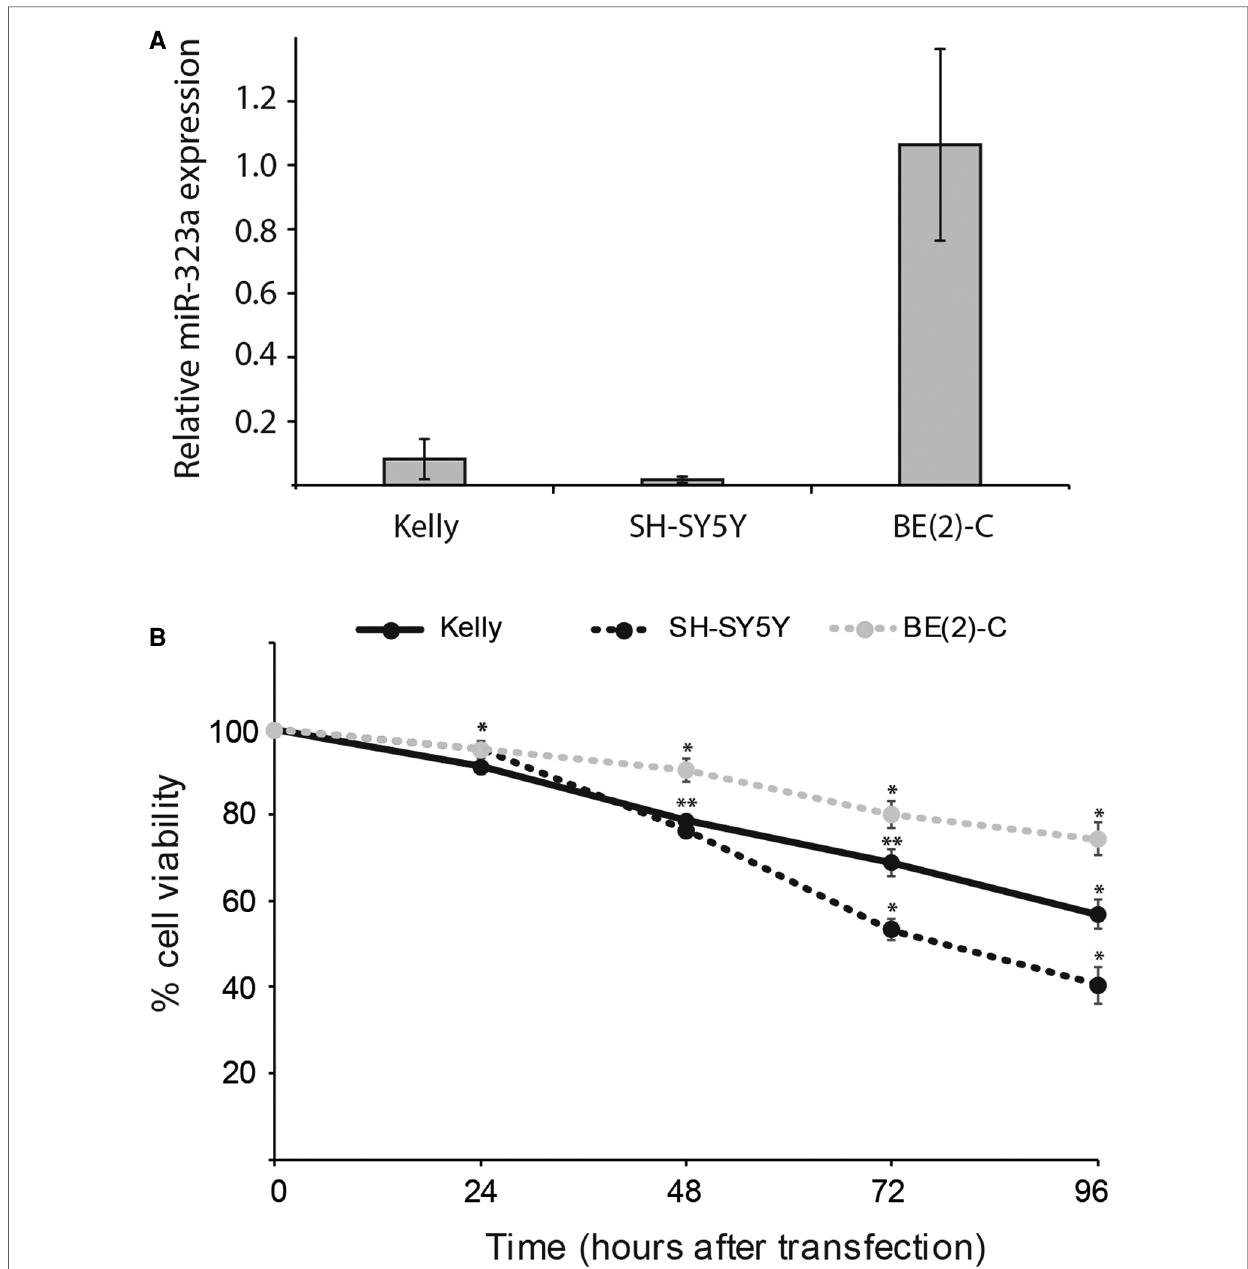
FIGURE 2 miR-323a-3p overexpression suppressed the growth and survival of neuroblastoma cells. (A) The basic expression of miR-323a-3p with respect to stably expressed miR-4286 in Kelly, SH-SY5Y and BE(2)-C cell lines were detected by RT-qPCR analysis. Data is presented as mean±SEM of at least three independent experiments, each repeated in triplicates. (B) Cell viability of the cell lines Kelly, SH-SY5Y and BE(2)-C at 24 h, 48 h, 72 h and 96 h post transfection with miR-323a-3p , measured with the alamarBlue cell viability assay. Data is presented as mean±SD of at least three independent experiments, each repeated in triplicates. * P <0.05, ** P <0.01 vs. the NC. RT-qPCR, reverse transcription-quantitative polymerase chain reaction; NC, negative control; miR, microRNA; SD, standard